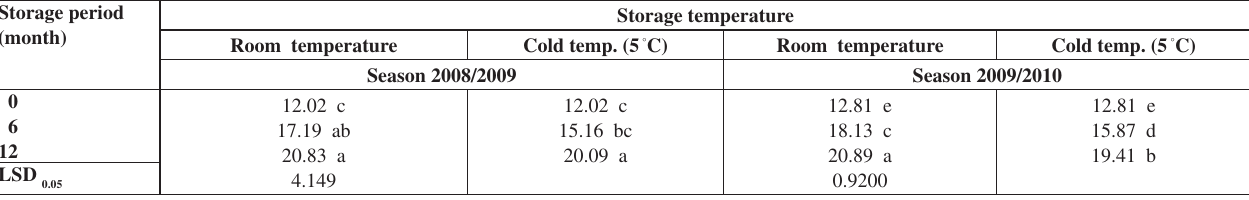
Table 24: Effect of the interaction between storage temperature and storage period on malondialdehyde content of onion seeds during seasons of 2008/2009